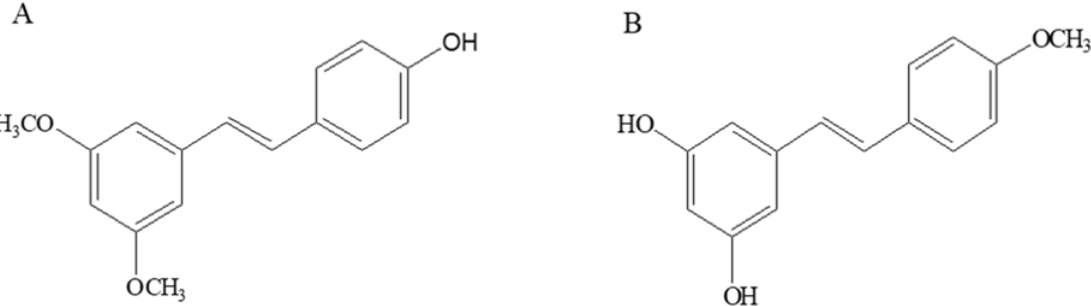
Figure 1. Chemical structure of ( A ) pterostilbene (Pte) and ( B ) 4 ′‐ methoxyresveratrol (4MR).